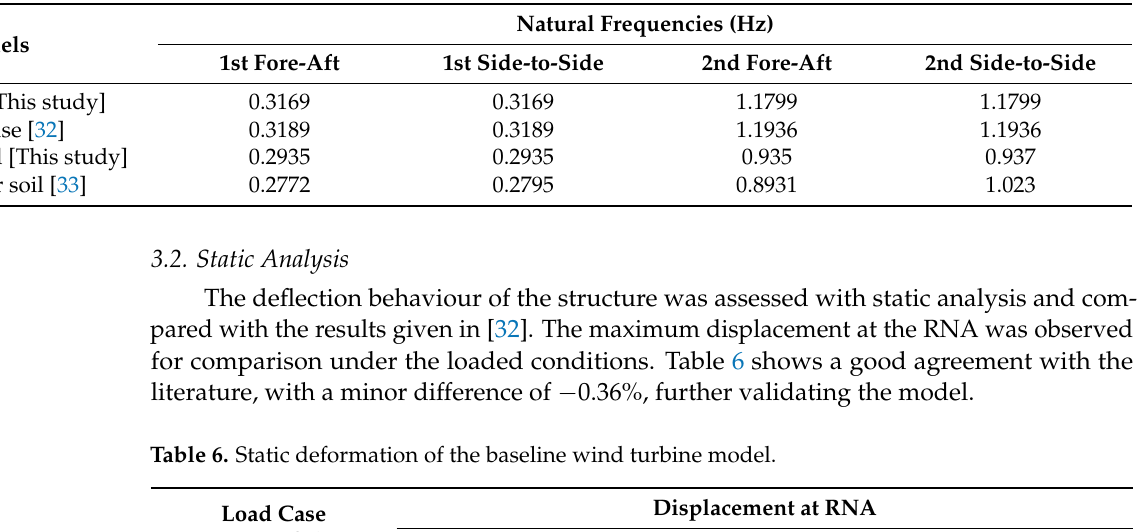
Figure 4. The power density of the NREL 5-MW wind turbine [26]. Table 5. Comparison of natural frequencies with the reference values.